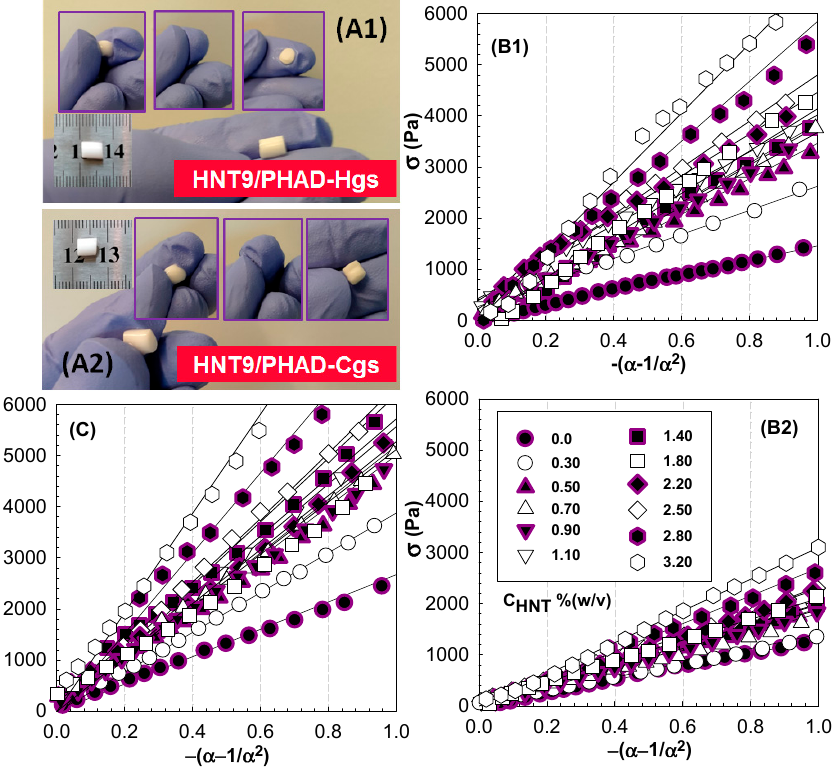
Figure 5. Optical images of HNT9-PHAD-Hgs ( A1 ) and HNT9-PHAD-Cgs ( A2 ) containing 2.50% ( w/v ) HNT, indicating that the samples are highly elastic to withstand high level of deformation under finger compression; ( B1 , B2 ) stress–strain isotherms of ternary HNTm/PHAD-Hgs for uniaxial compression in as-prepared state and that after equilibrium swelling in water; and ( C ) stress–strain isotherms of ternary HNTm/PHAD-Cgs after equilibrium swelling in water. HNT contents (in w/v %) are indicated in the